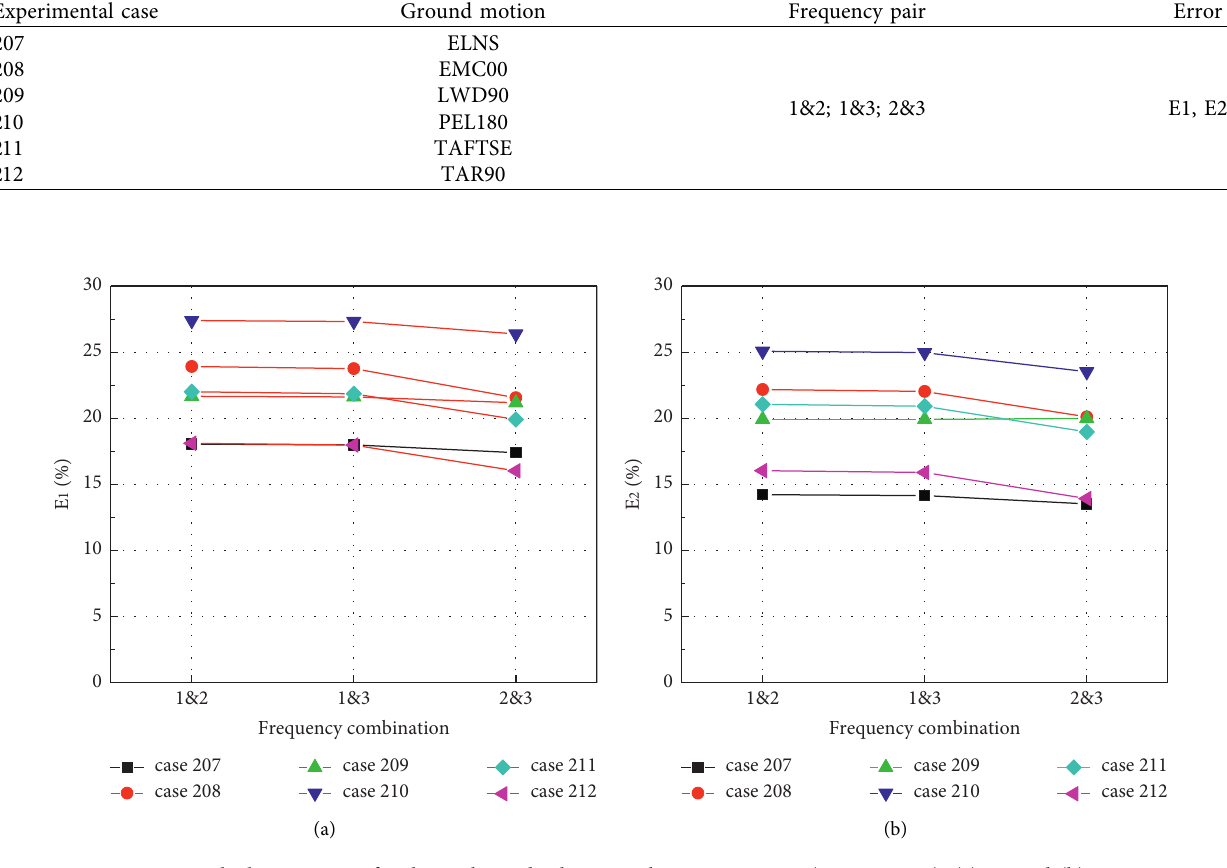
Figure 9: Calculation error of isolation layer displacement by using NP-RD (PGA � 0.07g): (a) E1 and (b) E2.